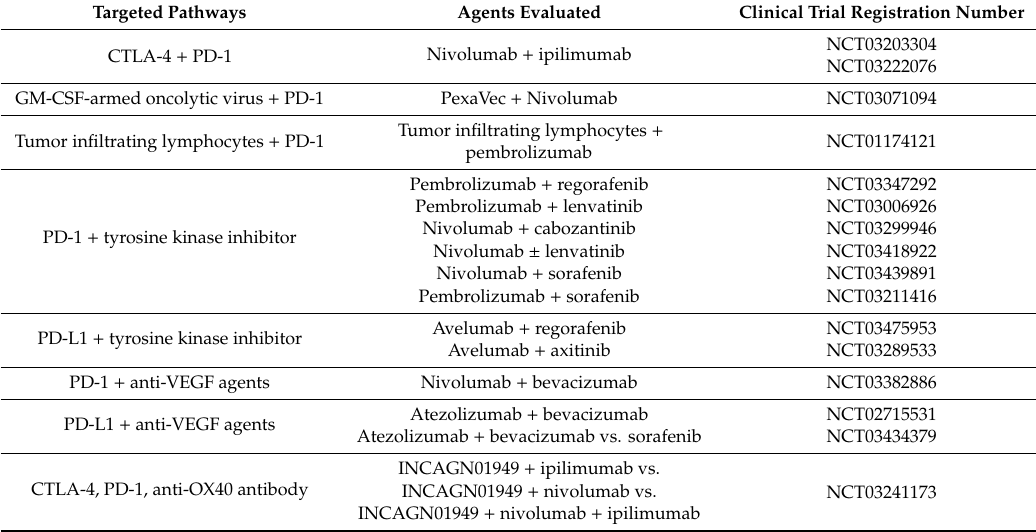
Table 2. Selective ongoing clinical trials of combination immunotherapy agents in advanced hepatocellular carcinoma.